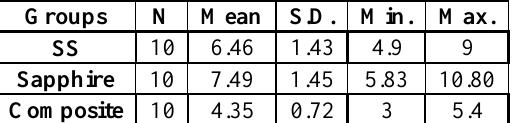
Table 1: Descriptive statistics of the shear bond strength (MPa) in different groups.